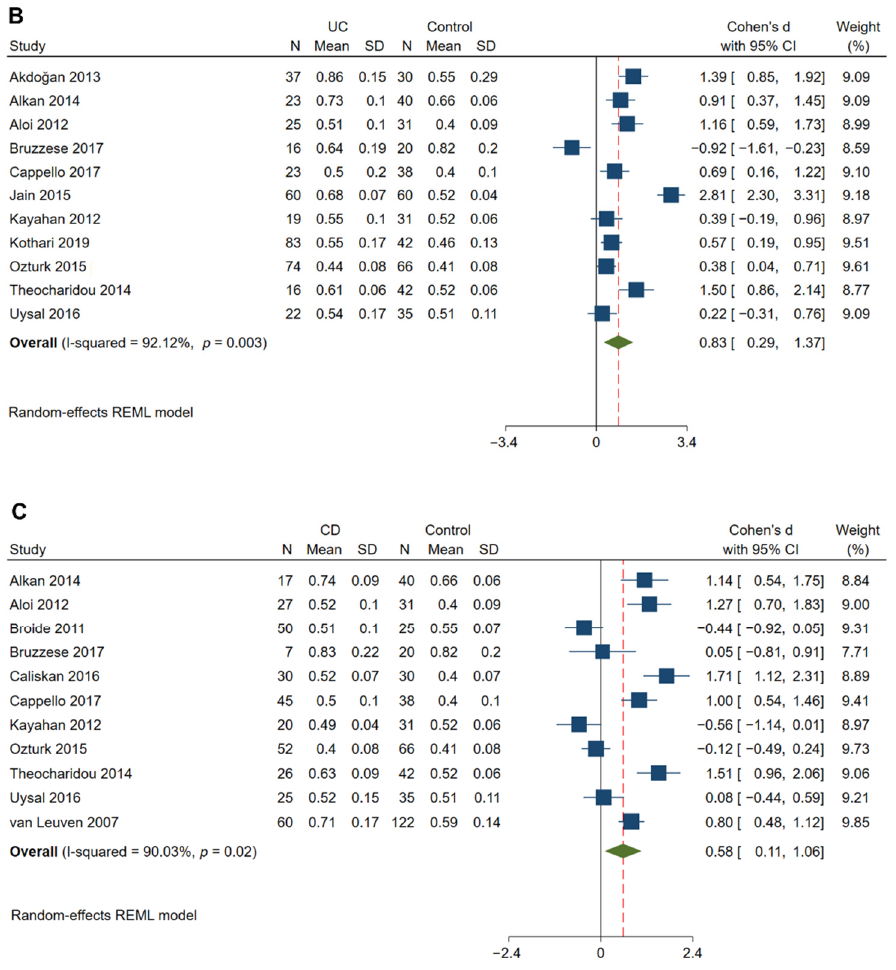
Figure 2. Meta-analysis of studies reporting on cIMT in patients with IBD compared to matched controls. Comparisons include overall IBD vs. control ( A ), UC vs. control ( B ), and CD vs. control ( C ). cIMT, carotid intima-media thickness; IBD, inflammatory bowel disease; UC, ulcerative colitis; CD, Crohn’s disease; REML, restricted maximum